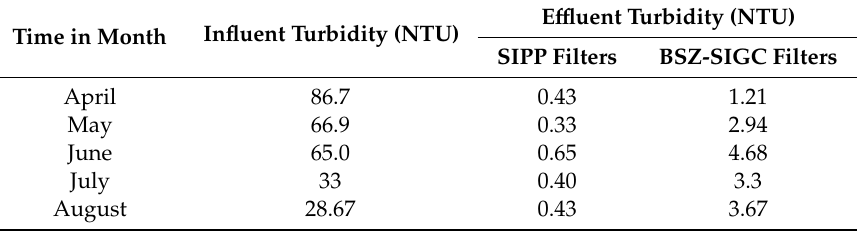
Table 6. The arithmetic mean results of the influent and e ffl uent turbidity during the study